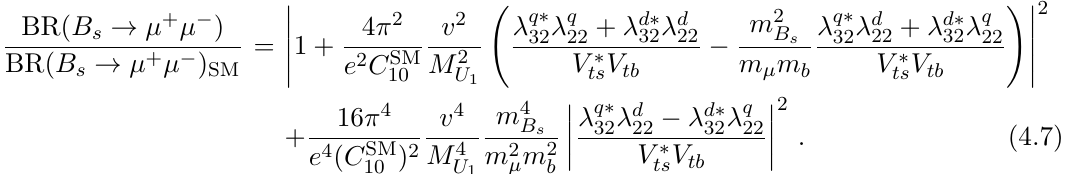
Figure 3 . Constraints on the U 1 leptoquark parameter space in the plane of the complex (cid:21) d coupling divided by the leptoquark mass for the benchmark points BM1 (left panel) and BM3 (right panel). The gray region is excluded by B s ! (cid:22) + (cid:22) (cid:0) at the 95% C.L.. The dashed blue line is the projected sensitivity of future experiments to the muon EDM. The red shaded region corresponds to the parameter space the can address the anomaly in the anomalous magnetic moment of the muon. The solid (dashed) purple lines represent the current constraint (projected sensitivity) from the neutron EDM, with the purple bands re(cid:13)ecting the uncertainty in the nucleon matrix element (cid:12) ~ G n